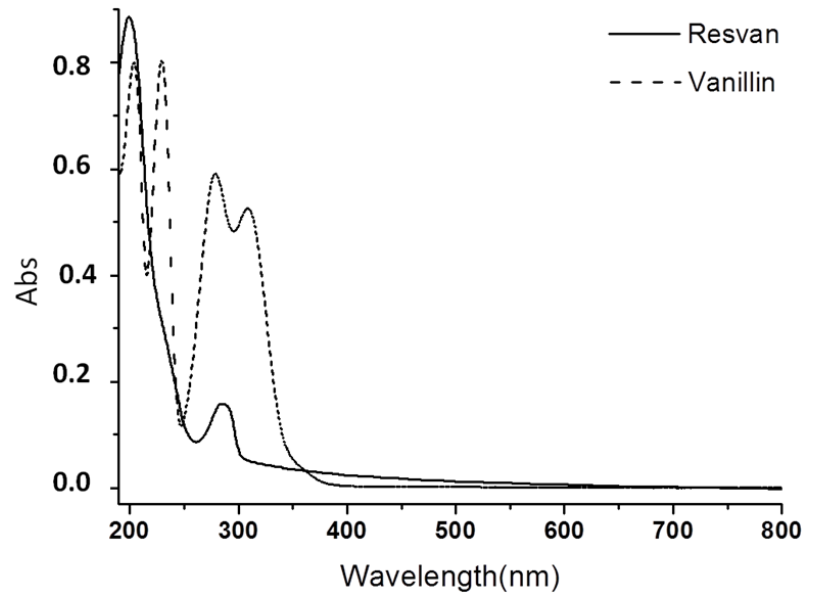
Figure 3. Electronic spectrum in water of resvan (5.5 × 10 − 5 mol L − 1 ) and vanillin (5.8 × 10 − 5 mol L − 1